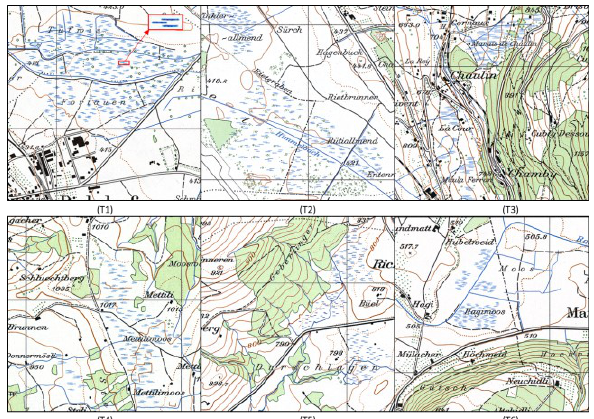
Figure 2. The selected map tiles and the template (in red bounding box from T1).